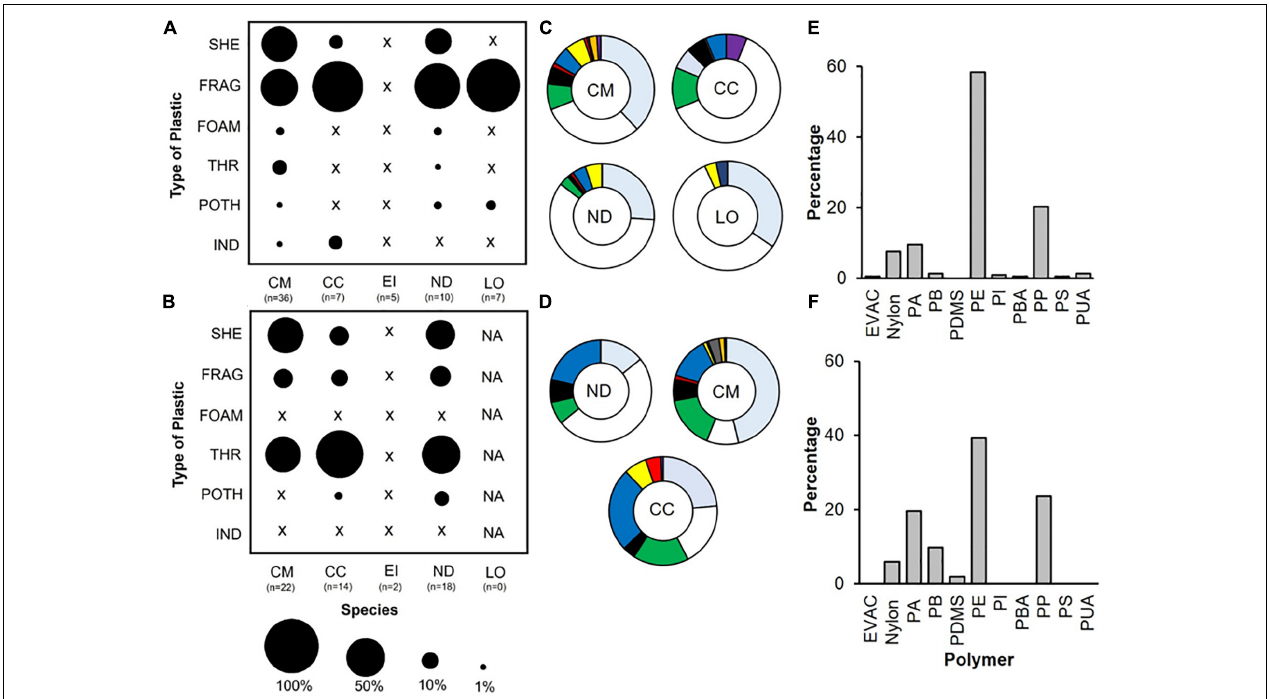
FIGURE 3 | Type and colour of ingested plastics from post-hatchling gut content; (A) proportion (%) of type of plastic pieces ingested by post-hatchling and oceanic juveniles for PO and (B) for IO. (C) Proportional makeup of plastics by colour in PO samples (D) IO samples. For all parts CM, Green ( Chelonia mydas ); CC, loggerhead ( Caretta caretta ); EI, hawksbill ( Eretmochelys imbricata ); ND, flatback turtles ( Natator depressus ); LO, olive ridley ( Lepidochelys olivacea) For parts (A and B), black circle scaled accordingly, x = no presence of particular type of plastic. SHE, sheetlike plastics; THR, threadlike plastics; FOAM, foamed